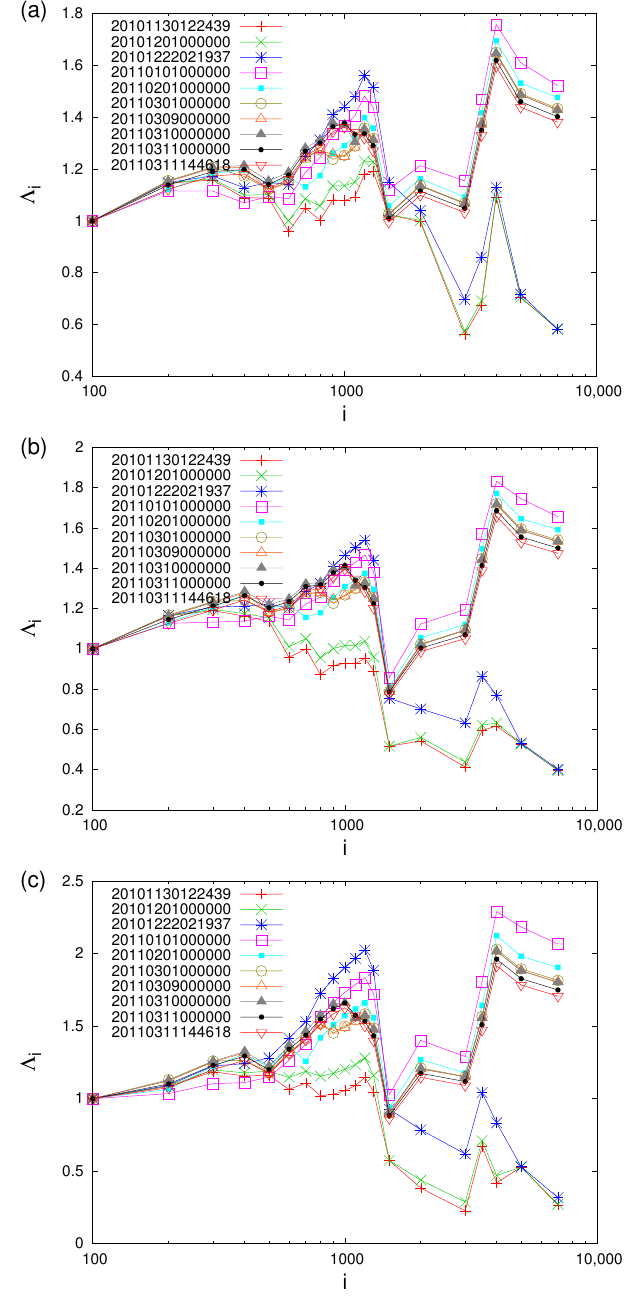
Figure 24. The same as Figure 22, but when the computation starts on 1 March 2010 ( a ), 1 May 2010 ( b ) and 1 July 2010 ( c ) for all M JMA ≥ 3.5 EQs. Taken from Ref.